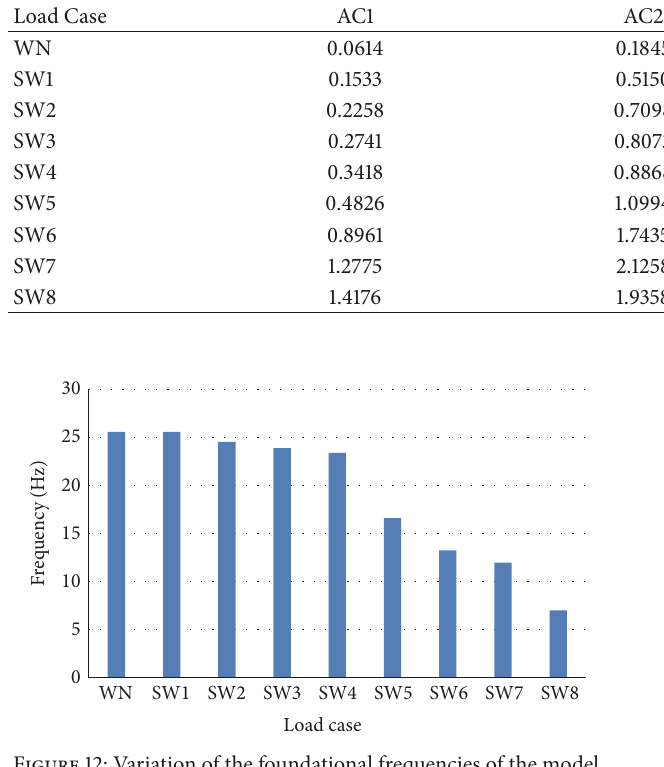
Figure 12: Variation of the foundational frequencies of the model.